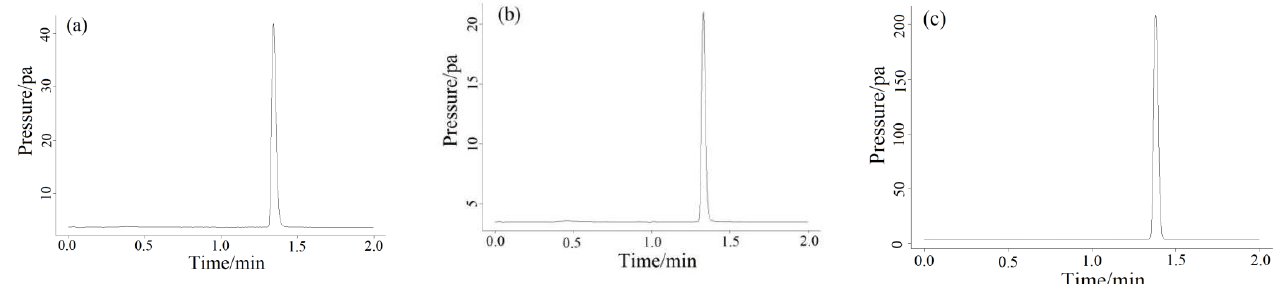
Figure 8. Three samples of methane gas produced by low-methane rice were randomly selected for detection. The detected concentrations of methane in ( a ) (F treatment), ( b ) (O treatment) and ( c ) (AC treatment) were 33.04208, 12.61878 and 172.73617 ppm, respectively.